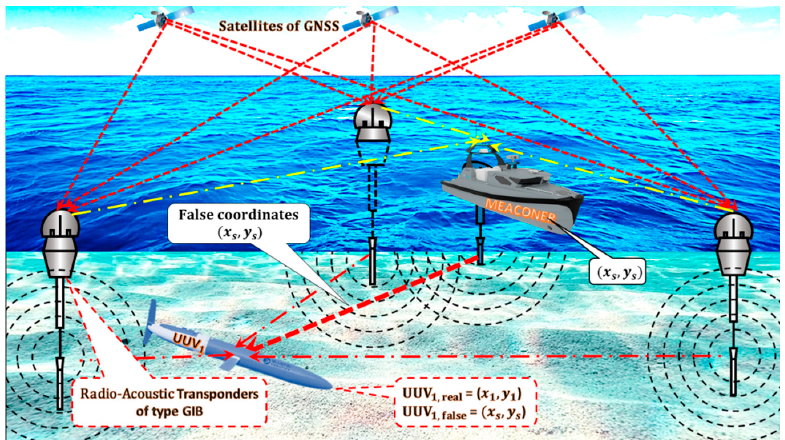
Figure 13. The basic LNSS meaconing scheme of UUVs: at some point in time, the meaconer determines its position ( x s , y s ) , introducing some delays into each of the satellite channels (the delay is determined by the difference in the GIBs signal paths from the GIBs and from the meaconer to the UUV navigator antenna) and transmitting the false position ( x s , y s ) on the same frequency of GIBs, which aims to deceive acoustic receivers and create a false PVT solution. All UUVs in the meaconer activation zone are positioned as UUV i,false = ( x s , y s ).